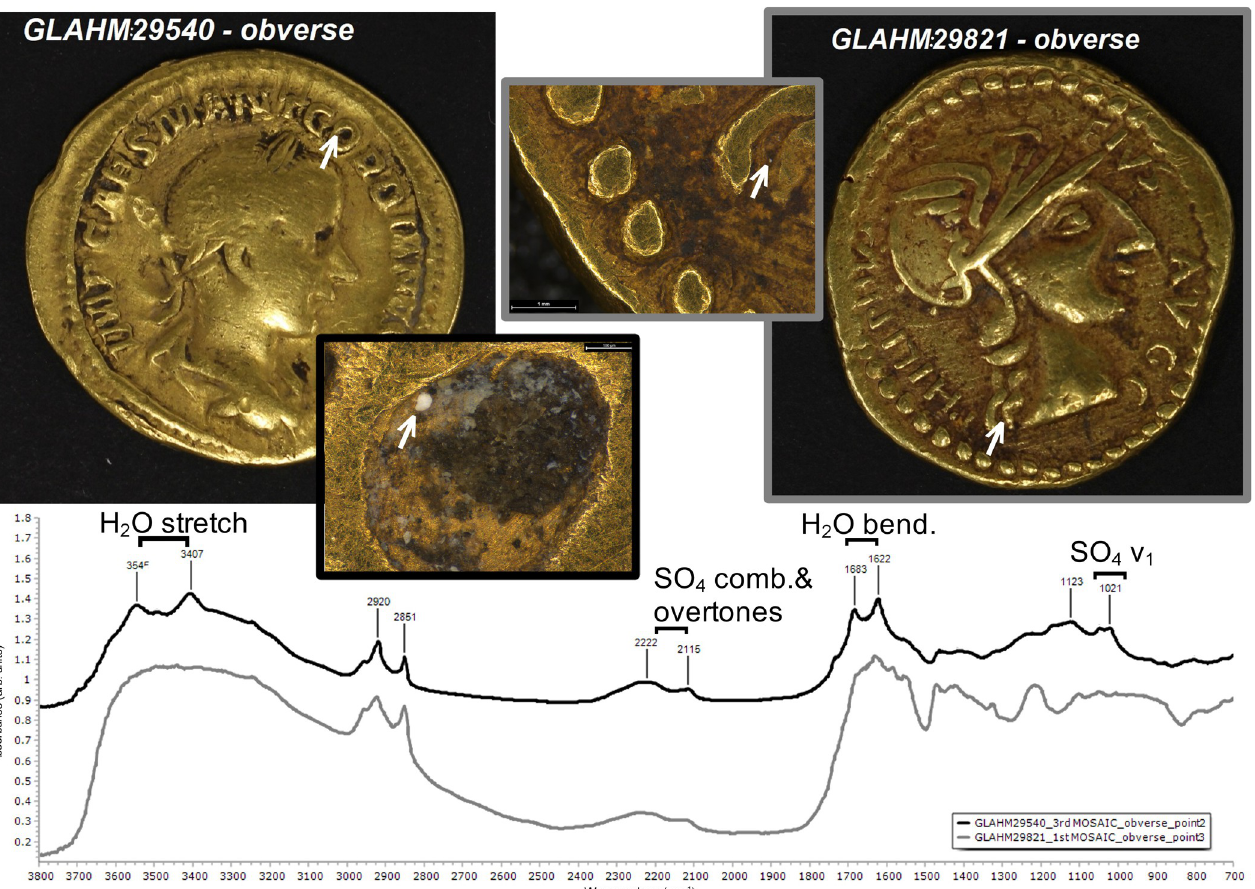
Fig 12. r-FTIR spectrum of light-coloured deposits on the obverse of the genuine Gordian GLAHM:29540 (black) and questionable Philip GLAHM:29821 (grey) coins. The spectra (see arrows for each spot) show gypsum as the predominant compound.